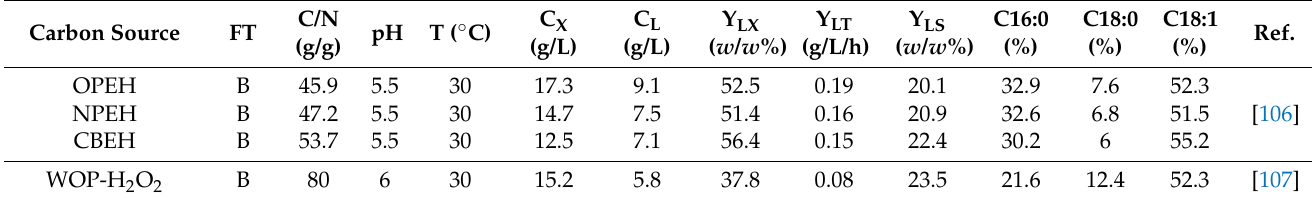
Table 6. Bioconversion of wastepaper to single-cell oil by the biocatalyst C. oleaginosus . Carbon